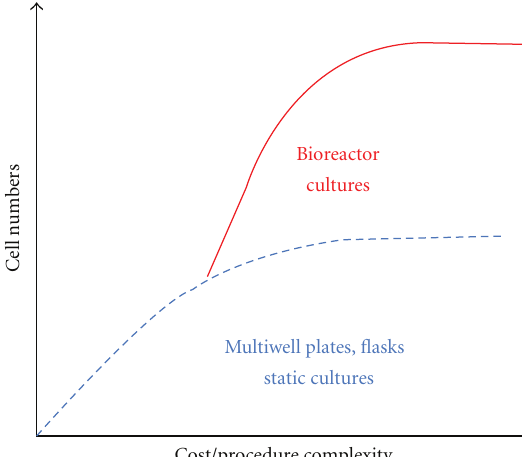
Figure 2: Increased cost and procedure complexity with large- scale cell requirements. As illustrated multiwell plates or flasks are ideal for the expansion of small numbers of antigen-specific CTLs ( < 5 × 10 7 ). However, this system becomes ine ff ective for the expansion of large numbers of cells. In contrast cell bioreactors are ideal for the production of large cell numbers, but this platform is di ffi cult to adapt and requires specialized equipment.